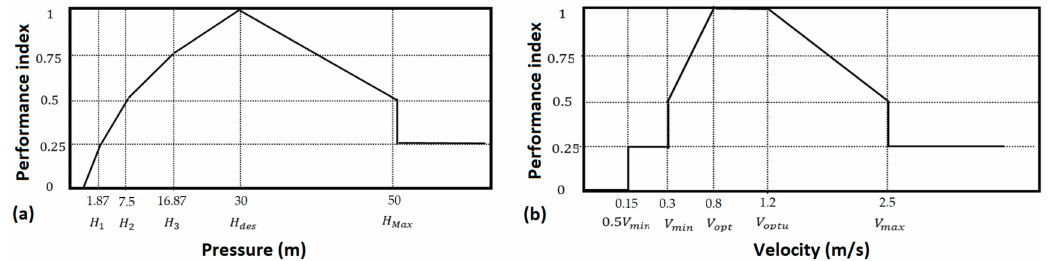
Figure 1. Modified penalty curves for: ( a ) pressure and ( b ) velocity based on the standard codes